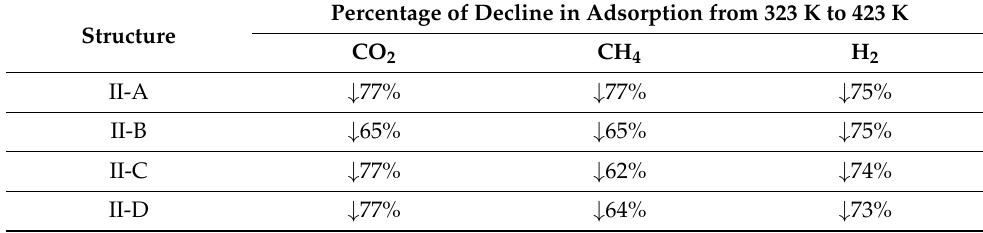
Table 1. Trend of adsorption in four kerogen structures with temperature increment at a fixed pressure.